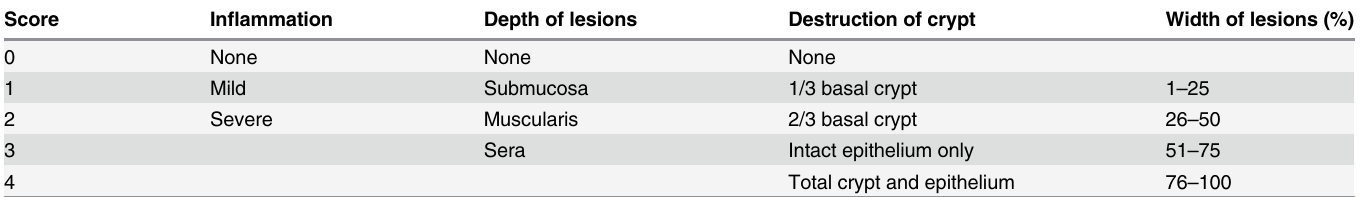
Table 2. Histological score to quantify the degree of